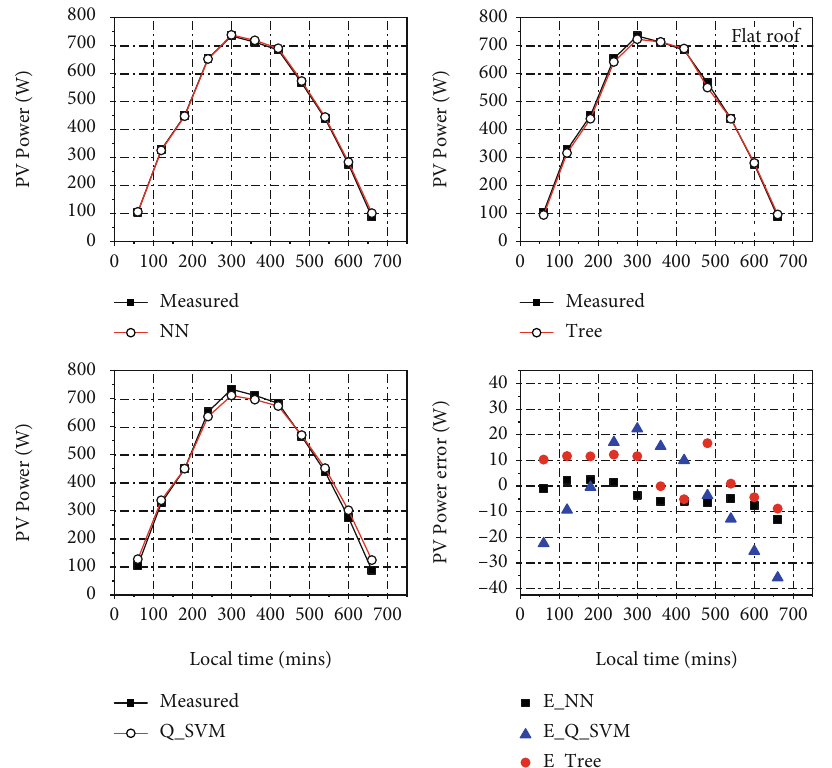
Figure 7: PV power prediction and error of the NN-QSVM-Tree models for fl at